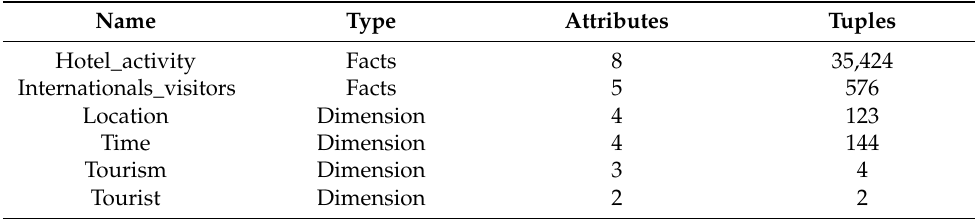
Table 10. Predicate usage matrix for the first experiment.